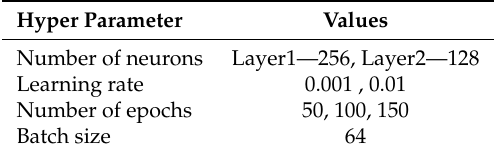
Table 6. Selection of the hyper parameters for